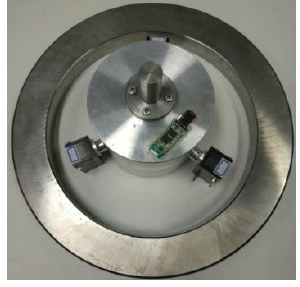
13 of 16 Figure 11. Verification experiment. Table 3. Experiment data of inner diameter measurement (mm).